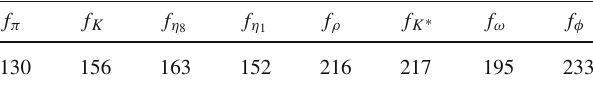
Table 1 Decay constants of light pseudoscalar and vector mesons col- lected from Refs. [46,47] (in unit of MeV). f η with the formulas in Ref.